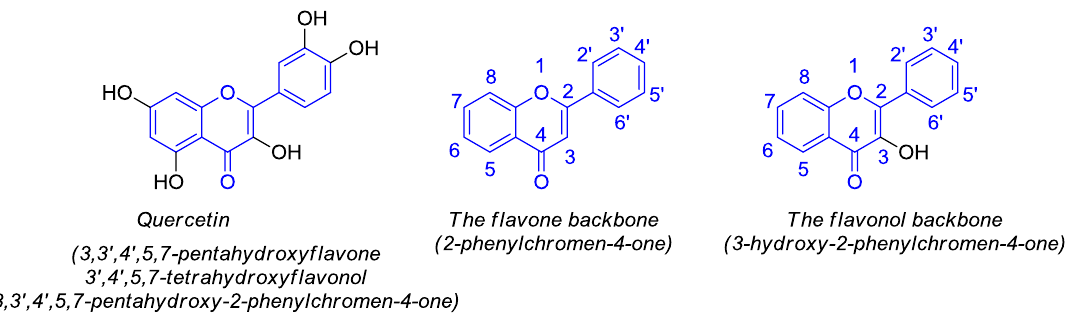
Figure 1. Structure of quercetin and representation of flavone and flavonol backbones.